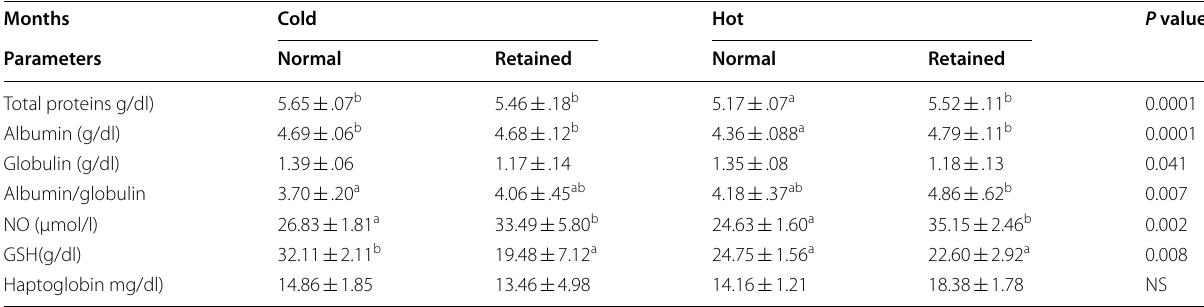
Table 2 Mean SD of total proteins, albumin, albumin/globulin ratio, nitric oxide, glutathione reduced and haptoglobin ± in dairy cows during winter/heat stress with and without retained fetal membranes